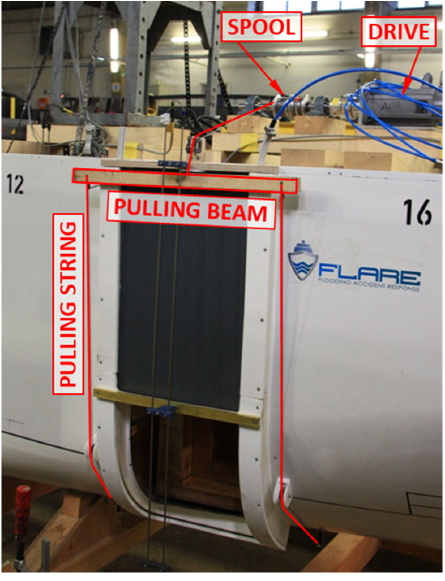
Figure A2. Damage opening mechanism for Damage Case 4.